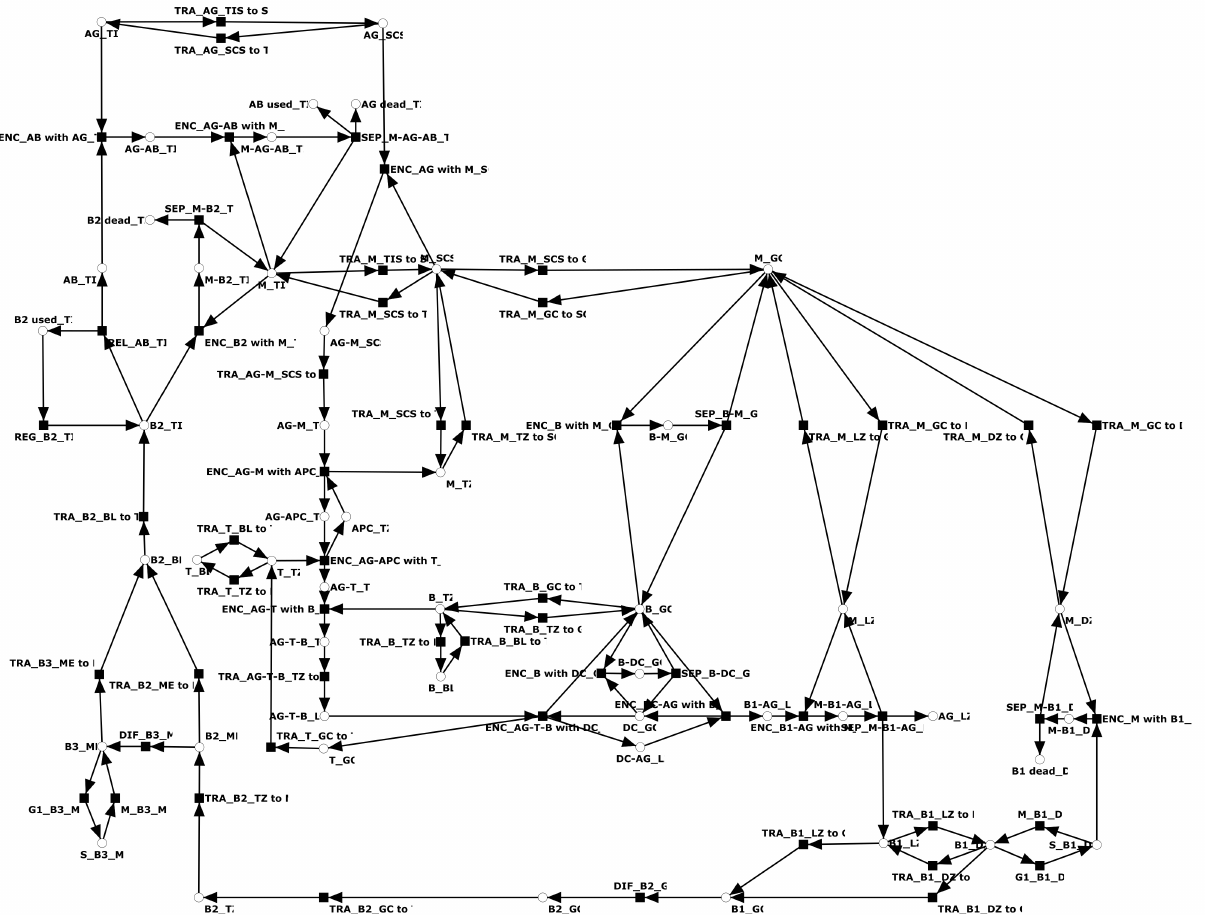
Figure A1. Graphical representation of the PBOPN (see text). The weights of all edges are set to one. All input transitions and all output transitions are